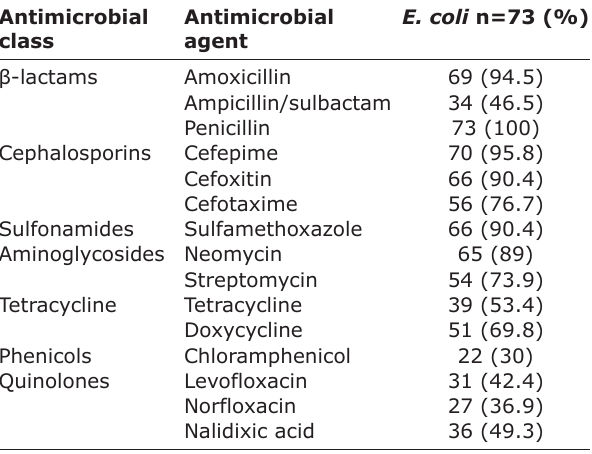
Table-3: Antibiograms of isolated E. coli strains. Antimicrobial class